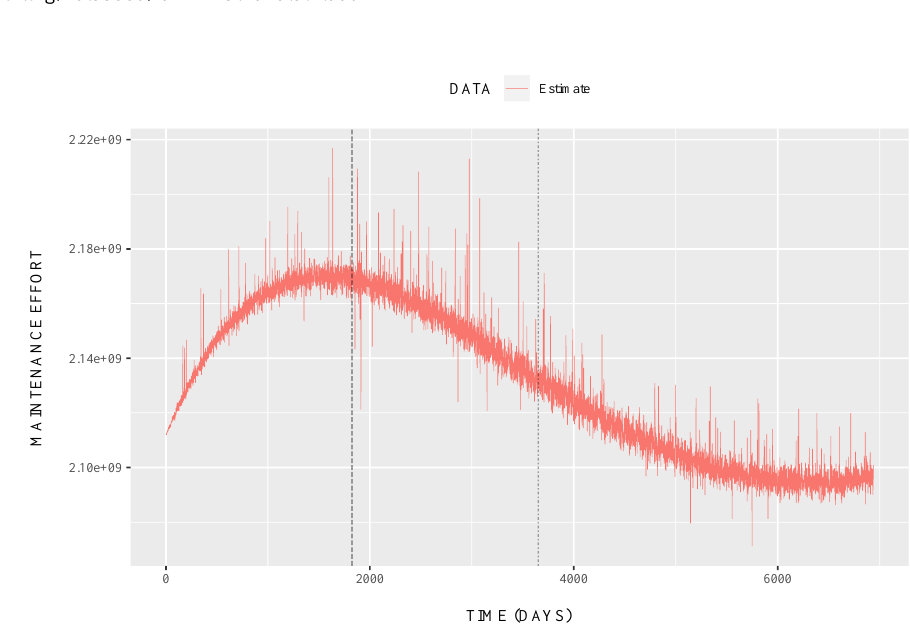
Figure 5. The sample path of estimated total OSS effort for S-shaped type